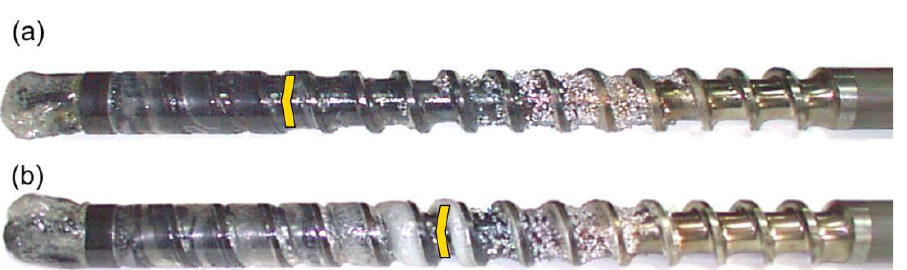
Figure 7. An effect of the screw speed on the polymer flow in the injection molding process at the plastication stroke h plast = 1 D, and the back pressure P back = 2 MPa: ( a ) N = 100 rpm, ( b ) N = 300 rpm.